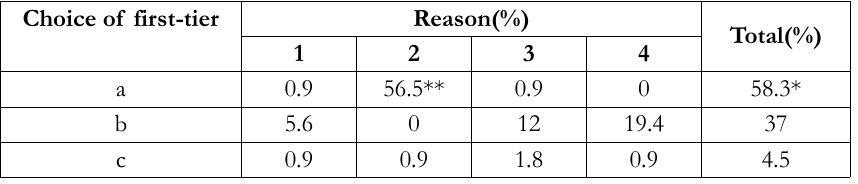
Table 6. Percentage of each response combination for item 3 on